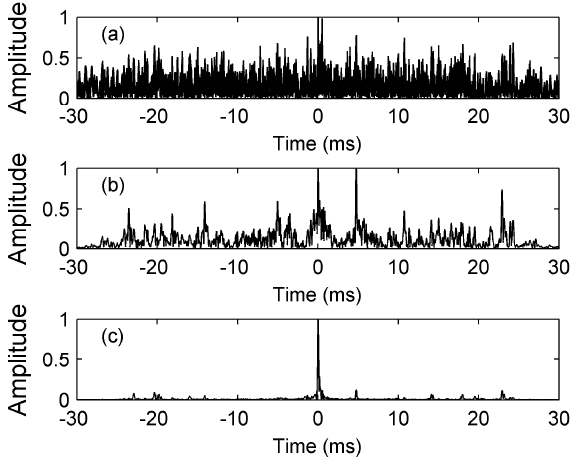
Figure 8. Normalized outputs of the MF, the FDAMF, and the TRC-IS-FDAMF when the input SNR =